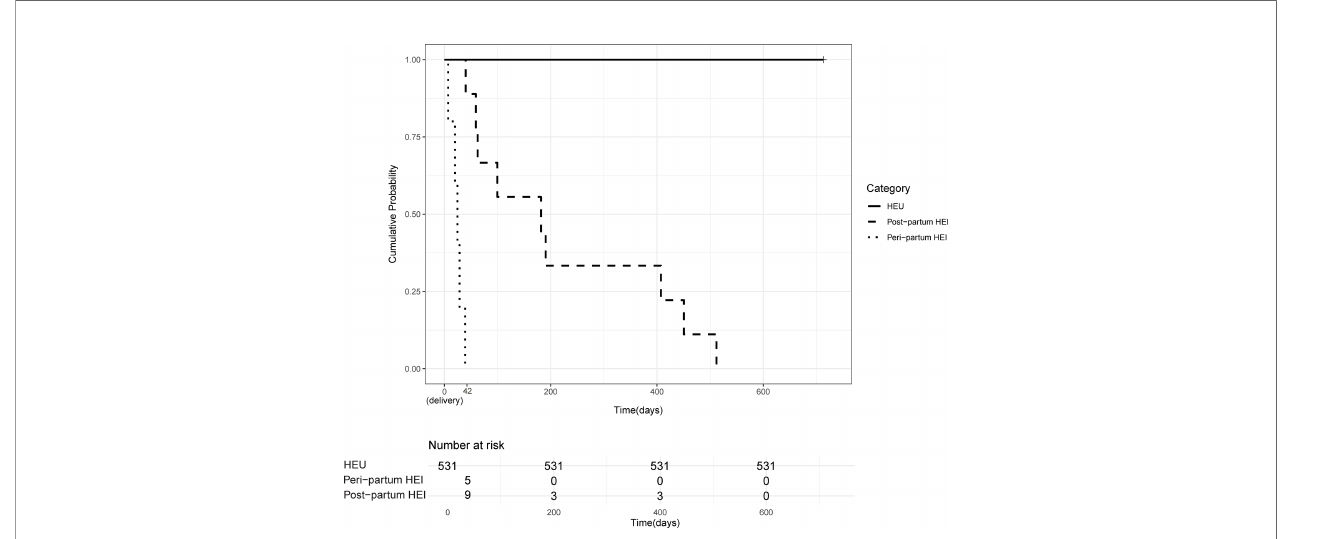
FIGURE 2 | Timing of HIV mother-to-child-transmission. Kaplan – Meier probability of HIV transmission among HIV-exposed infants over the 24-month follow-up period. Cases of HIV-MTCT were grouped according to timing of transmission; peripartum (from birth to 6 weeks of age), postpartum (after 6 weeks of age), and the exposed but uninfected (HEU) groups. Time line in the x axis is in days and time zero is at birth.